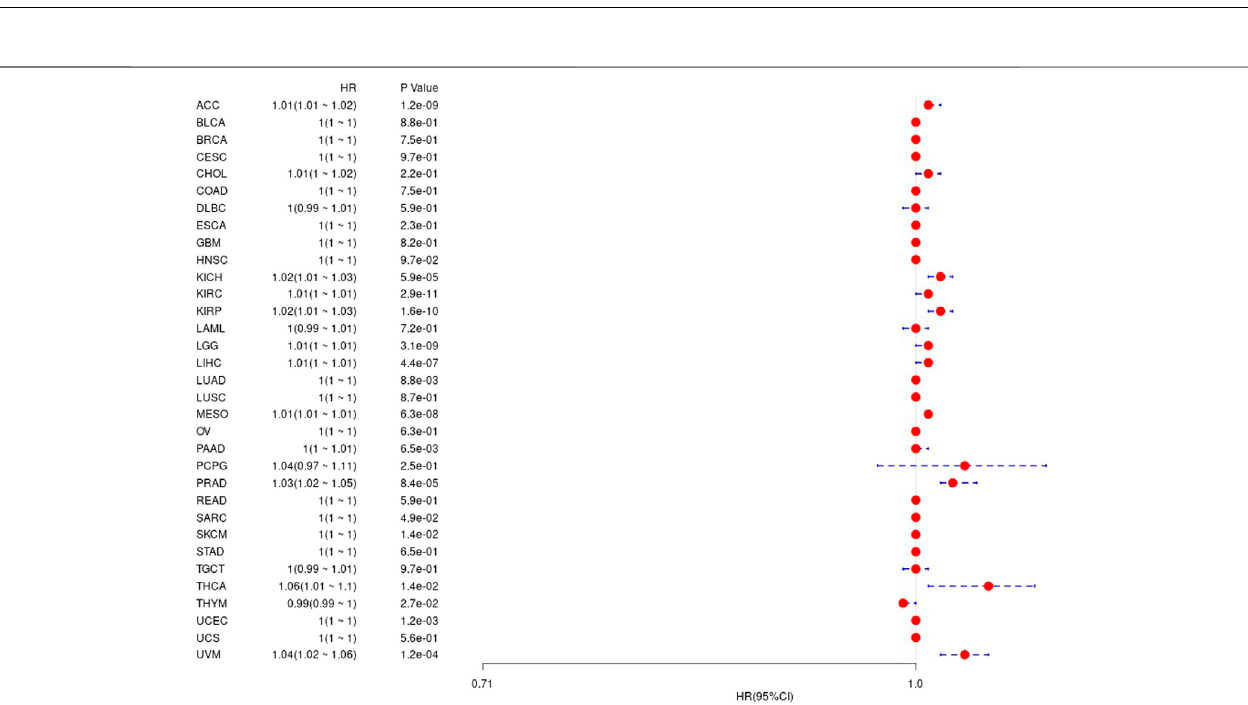
FIGURE 4 | The relationship between UBE2C gene and overall survival time in days in TCGA tumor and nontumor.